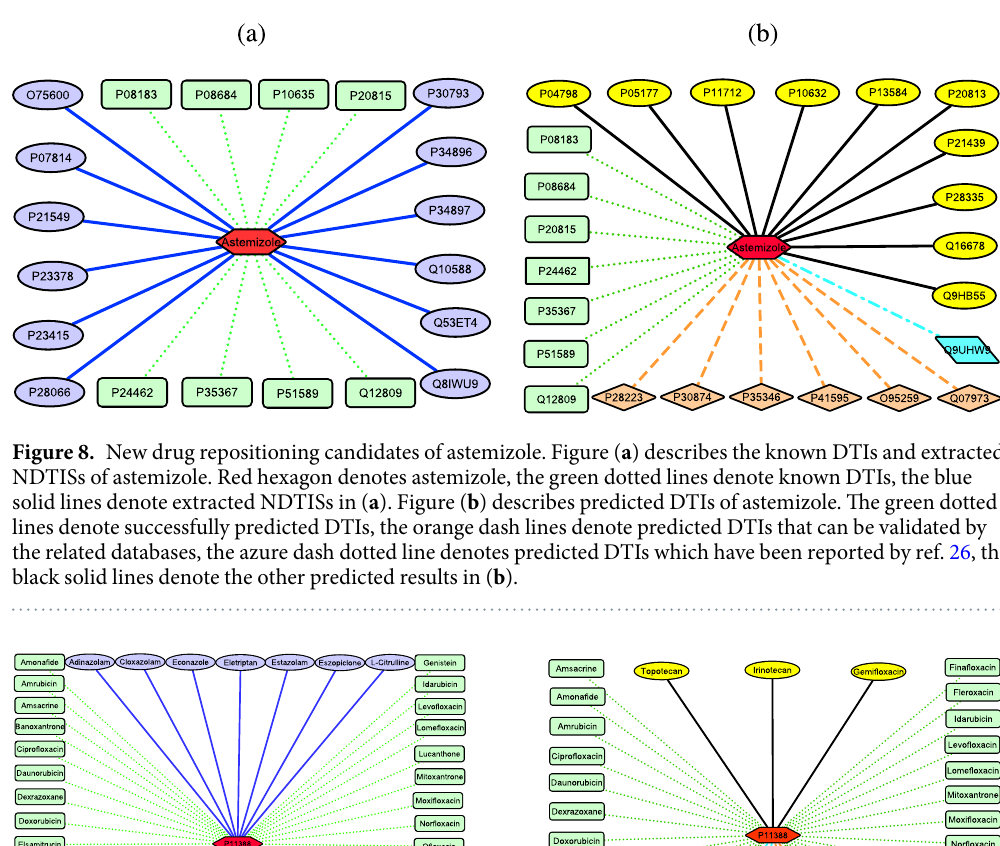
are 0.86 and 0.753 in the SuperTarget database, respectively 41 . Therefore, we inferred that P21439 may be new drug repositioning candidates of astemizole based on the predictive accuracy of PUDTI, functional similarity, sequence similarity and sequence identity to known target. Drug Repositioning for DNA topoisomerase 2-alpha. DNA topoisomerase 2-alpha (P11388) encoded by the TOP2A gene is used to control topological states of DNA. It is essential for segregating daughter chro- mosomes during mitosis and meiosis 38 . We intended to find new drug repositioning candidates for the protein from the DrugBank database 38 by training SVM-SW classification model after determining the performances of PUDTI. P11388 interacts with thirty-two drugs in the DrugBank database 38 . Most of these drugs are used to interfere with the transcription process and prevent the RNA synthesis 38 . We extracted thirteen negative DTIs for the proteins, where eight of these extracted negative DTIs have been reported by ref. 26. We used cytoscape 39 to draw DTI networks. Figure 9(a) listed known DTIs in the DrugBank database 38 and reliable NDTISs extracted by algorithm 1. We predicted possible interaction partners for P11388 based on known DTIs and extracted NDTISs. The predicted results were shown in Fig. 9(b). These DTIs can be divided into four parts: the first part includes known DTIs in the DrugBank database 38 , wherein twenty-seven of thirty-two known DTIs are identified by our proposed PUDTI framework. The second part includes DTI candidates that are unknown in the DrugBank database 38 but can be validated by retrieving the other databases. Among these DTIs, the interaction between dactinomycin